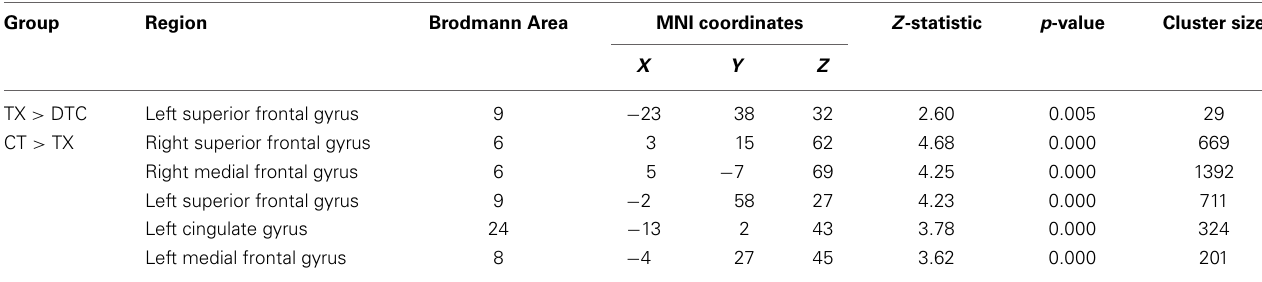
Table 5 | Results of between-group pairwise posttest comparisons using frontal ROI masks. Group Region